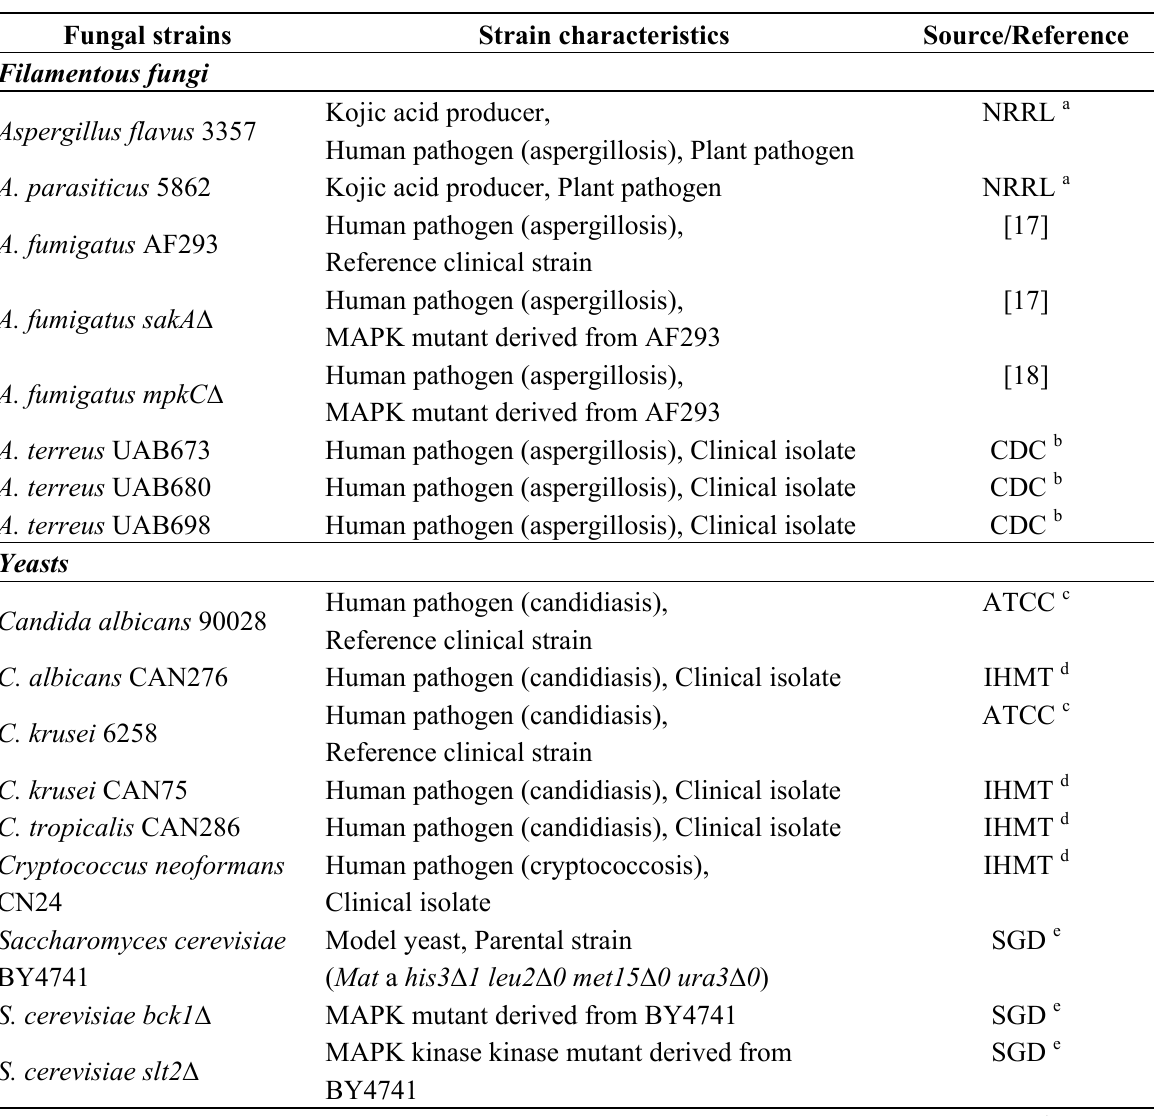
Table 1. Fungal strains used in this